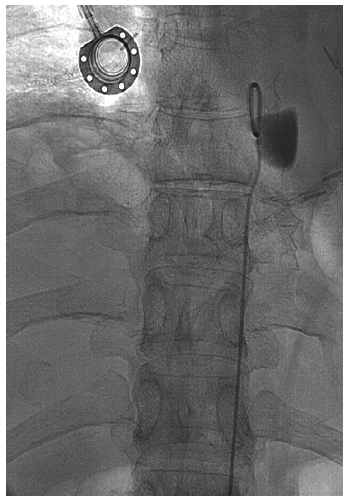
Figure 4: Two weeks after chemoembolization. Selection of the T8 intercostal artery. Note that a laterally projecting outpouching of stagnant contrast was noted, consistent with pseudoaneurysm. The opacifying portion of the pseudoaneurysm measured about 2-3cm in size with a 5mm